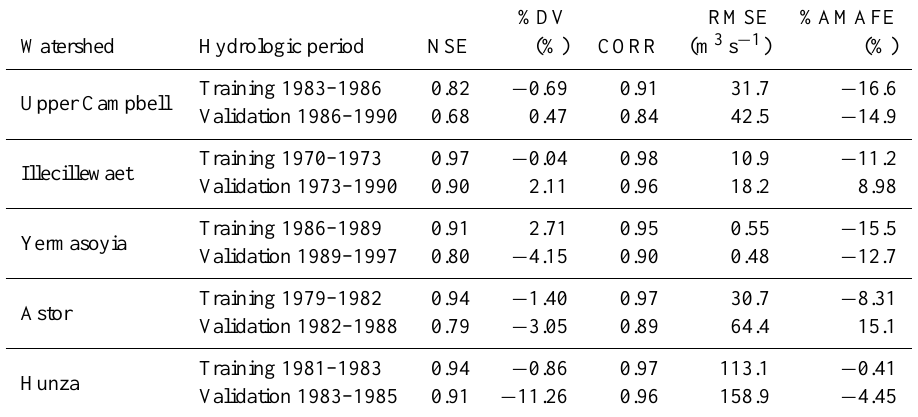
Table 6. Statistical indices of streamflow simulation with the proposed methodology for poorly gauged watersheds – UBCANN method.